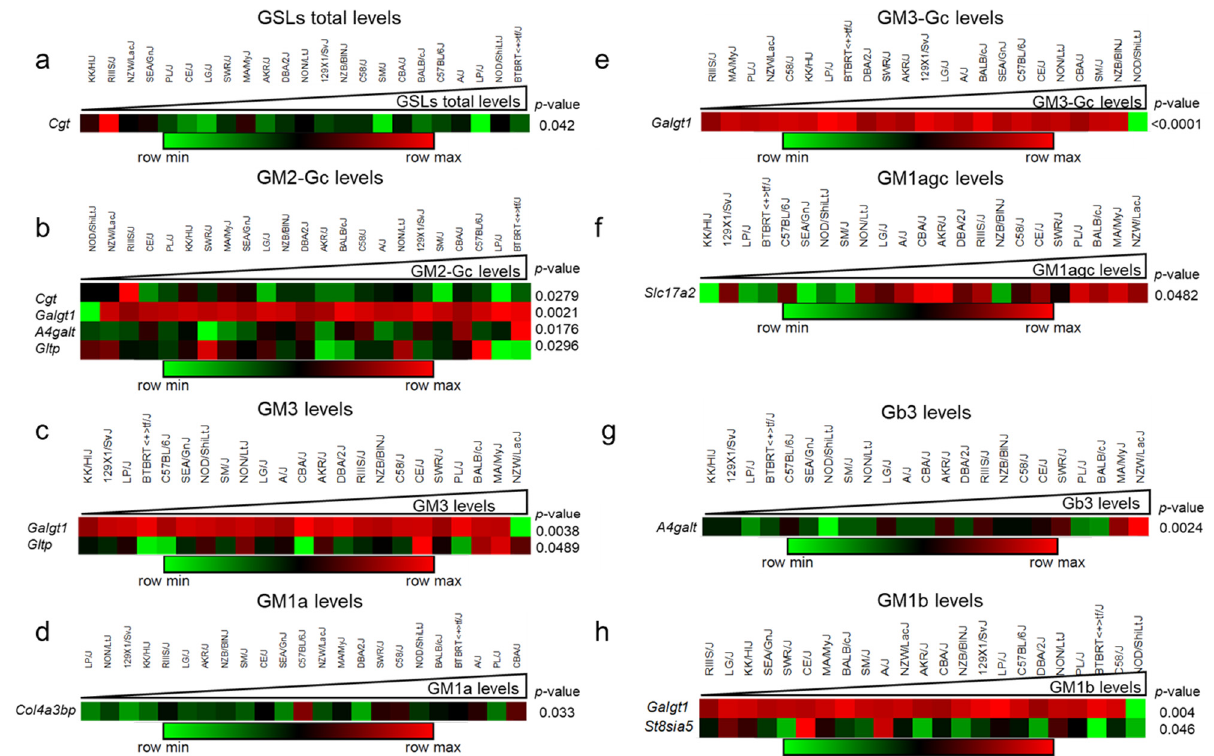
Figure 4. Correlations between GSLs and the mRNA levels of the GSL biosynthetic genes. ( a ) total genes with significant p values with its trait using Pearson’s correlations ( p ≤ 0.05) were plotted.